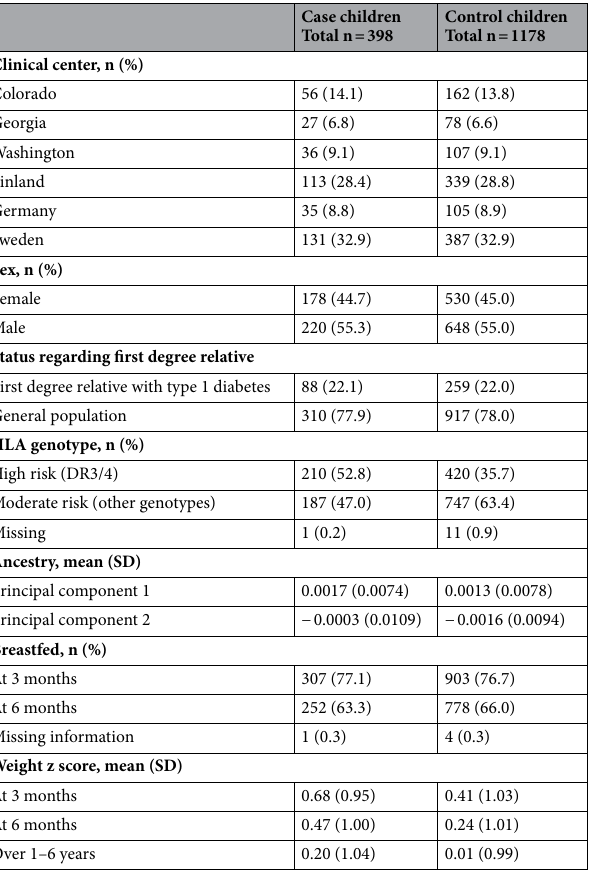
Table 1. Characteristics of TEDDY children with islet autoimmunity and control